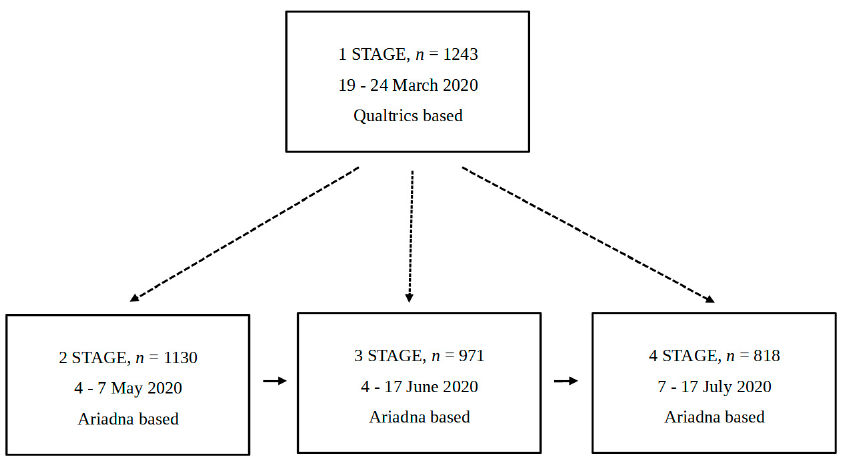
Figure 1. Research scheme used in the